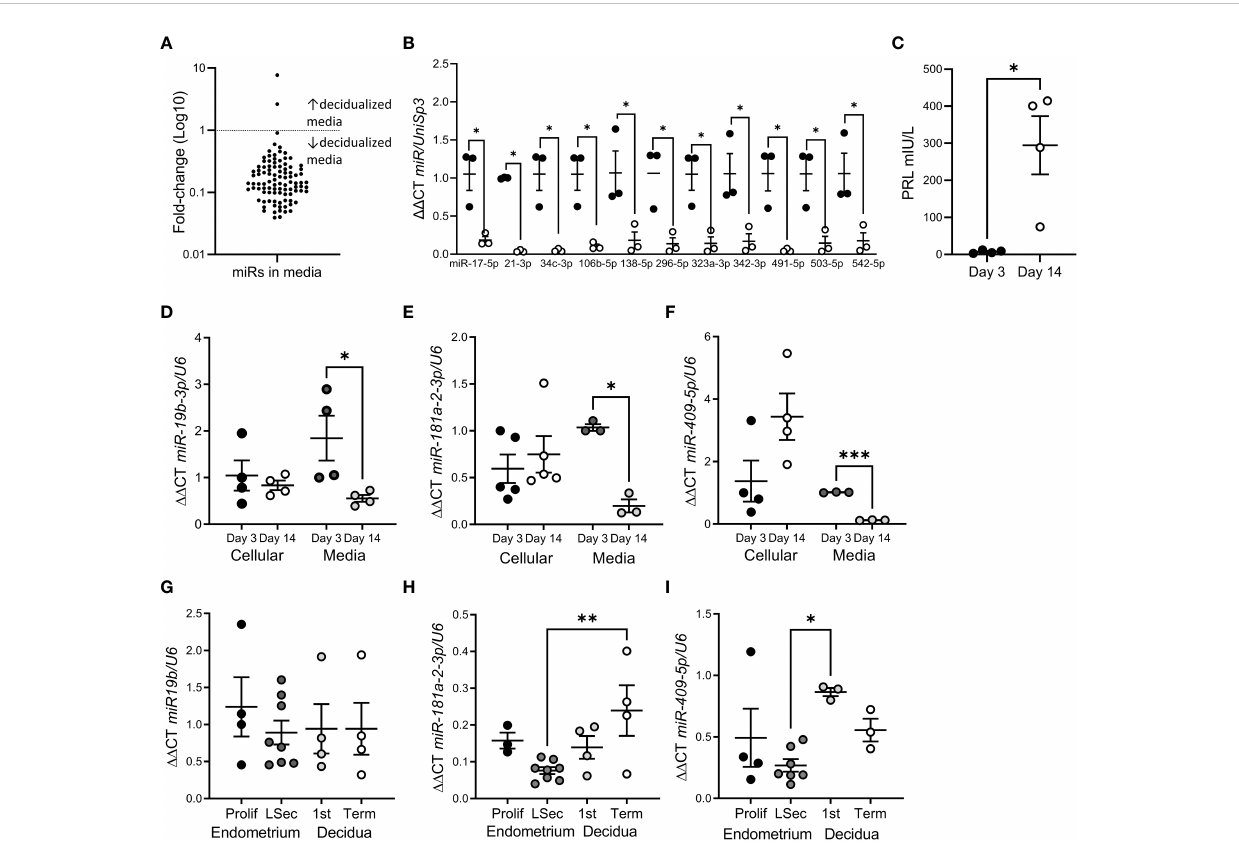
FIGURE 1 miR release was reduced following hESF decidualization. (A) Fold-change of all miRs identi fi ed in hESF culture media by microarray from Day 3 to Day 14. (B) miRs with signi fi cantly reduced levels in hESF culture media between Day 3 and Day 14. (C) . Prolactin (PRL) secretion by hESF on Day 3 and Day 14 of decidualization. (D – F) . qPCR of miR-19b-3p (D) , miR-181a-2-3p (E) and miR-409-5p (F) in hESF cells and culture media on Day 3 and Day 14 of decidualization. (G – I) . qPCR of miR-19b-3p (G) , miR-181a-2-3p (H) and miR-409-5p (I) in whole tissue biopsies collected during the proliferative (prolif) and late secretory (LSec) stages of the menstrual cycle and 1 st trimester and term decidua. Data shows mean ± SEM; *P<0.05; **P<0.01; ***P<0.001; (C – F) , paired t-test; (G – I) , one-way